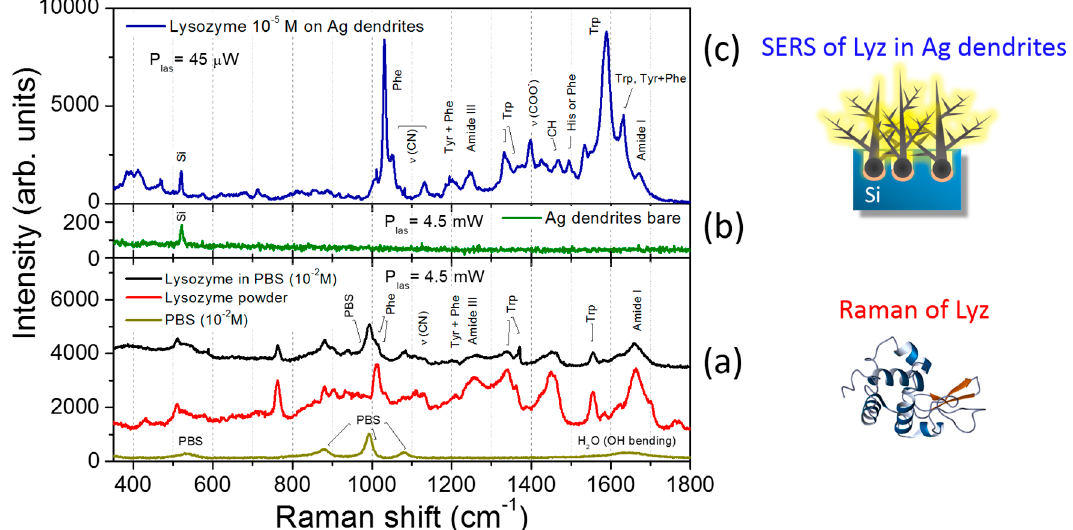
Figure 5. Surface-enhanced Raman scattering (SERS) performance of Ag dendrites. ( a ) Comparison between the Raman spectra of the lysozyme dry powder (red line), the pure phosphate buffer saline (PBS) solution (dark yellow line), and lysozyme in the PBS solution at 10 mM (black line). Notice that for these latter two spectra performed onto liquid samples, we used glass microcells as holders. ( b ) shows the Raman spectrum acquired on the bare Ag dendrites, while the blue spectrum in ( c ) shows the SERS response of 10 − 5 M of lysozyme onto the Ag dendrite platform. For all the spectra, we used the same 100× microscope objective with an integration time of 30 s. We used a laser power of 4.5 mW for the Raman spectra in ( a , b ) and 45 μ W in the spectrum shown in ( c ).